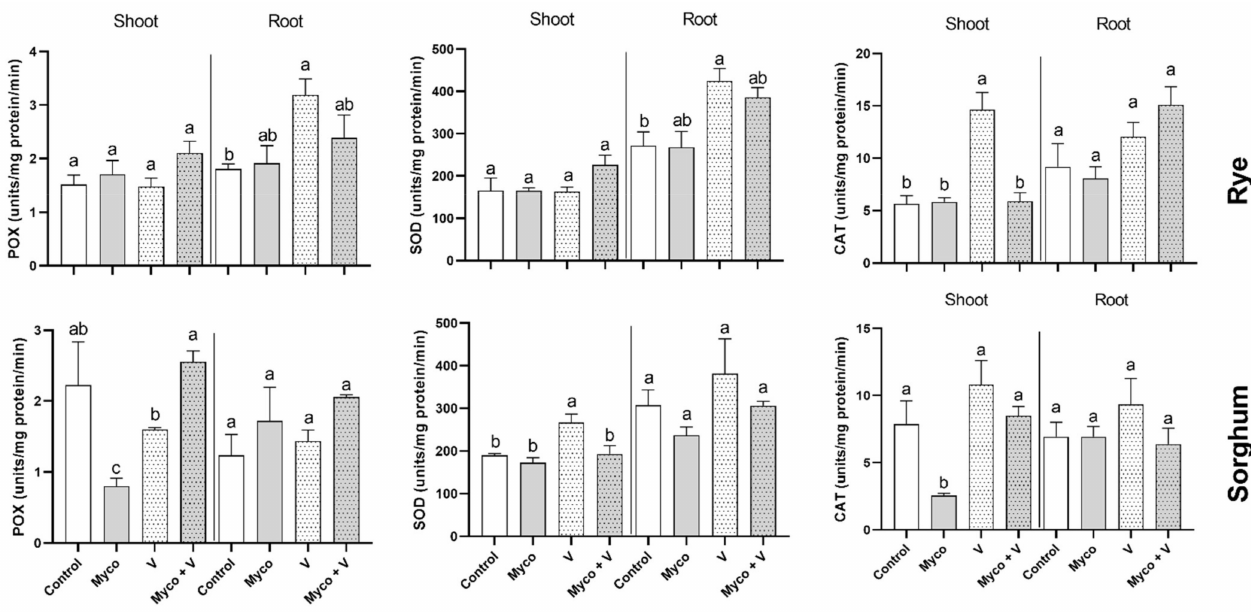
Figure 6. Changes in H 2 O 2 scavenging enzymes (POX, SOD, and CAT) in shoots and roots of six-week-old rye and sorghum grown in soils with 0 or 350 mg/kg soil sodium vanadate and with or without soil enrichment with inoculum of the mycorrhiza Rhizophagus irregularis . Data are mean values ± SE ( n = 3). Data were statistically analyzed by one-way ANOVA followed by Tukey posthoc test for comparing the means. Different letters indicate statistically significant difference between means of the same plant species at significance level of at least ( p ≤